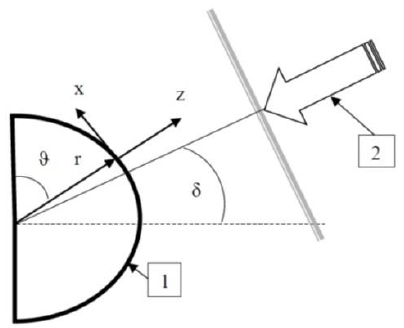
Figure 1. Coordinate system. 1 — illuminated hemisphere of the Earth; 2 — flux of ionizing radiation from a solar flare; ϑ — colatitude of the observation point, r — radius vector of the observation point, from a solar flare; ϑ —colatitude of the observation point, r —radius vector of the observation point, δ — solar declination angle. δ —solar declination